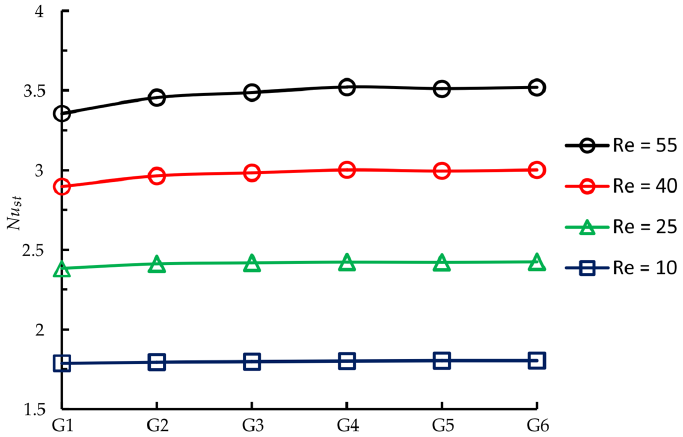
Figure 4. The grid independency test.